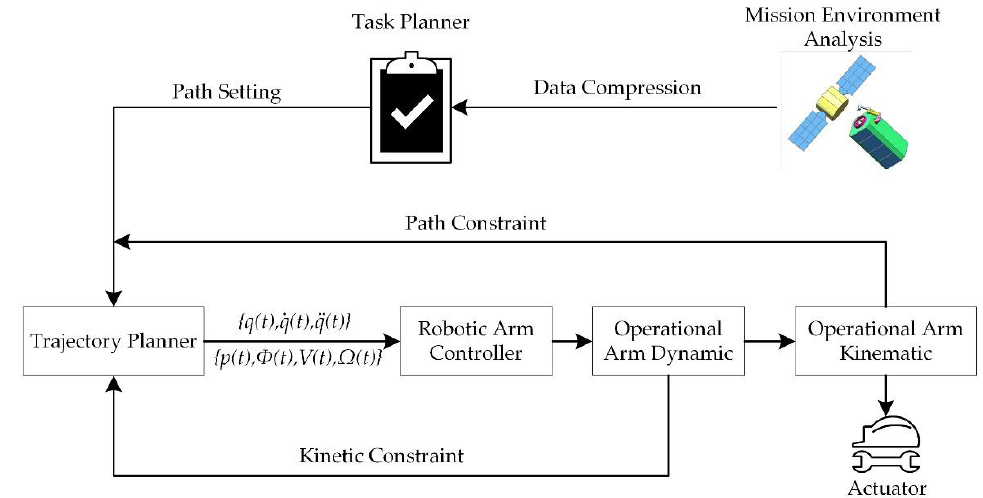
Figure 2. Diagram of the robotic arm tasks planning.